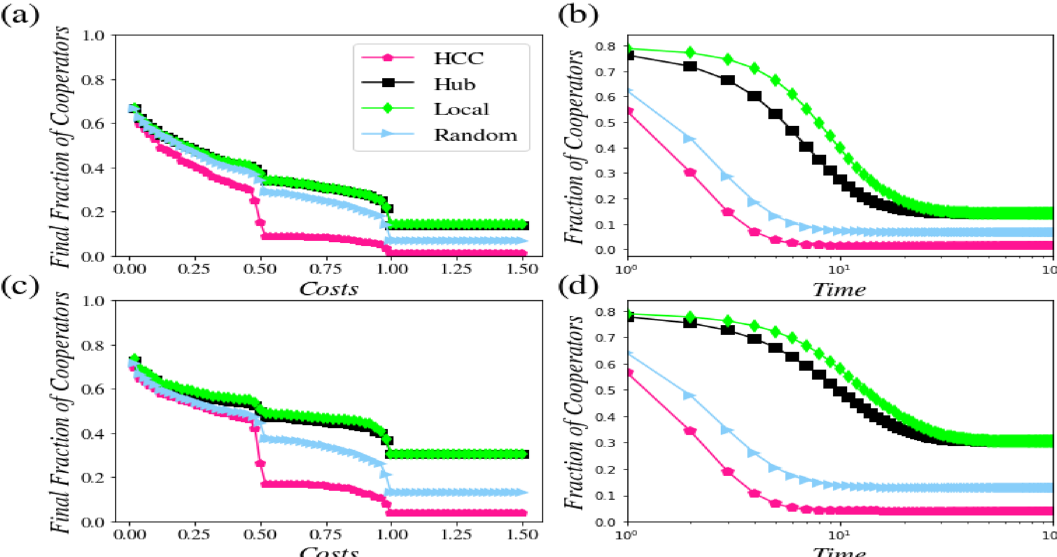
Figure 2. In dense and sparse networks with 400 nodes: an investigation into the effect of an initial choice of the free-rider nodes on controlling the scale-free networks through a deterministic update. ( a ) An analysis of the cooperation level in a dense network: An increase in the cooperation cost will lead to a decrease in the amount of cooperation. Under similar conditions, the nodes with the highest control ability, lead to a lower level of cooperation. ( b ) An analysis of the dense network’s dynamics: if the driver nodes are selected as the free- riders, the cooperation level will decrease ( c = 1 ). ( c ) An analysis of the cooperation level in a sparse network: In random selection and nodes with the highest control power, compared by selecting hub and local nodes, will lead to a higher level of cooperation. ( d ) An analysis of the dynamics of a sparse network: just like a dense network, the velocity of achieving a steady state is higher, where the nodes with the highest control power are selected ( c = 1 ).